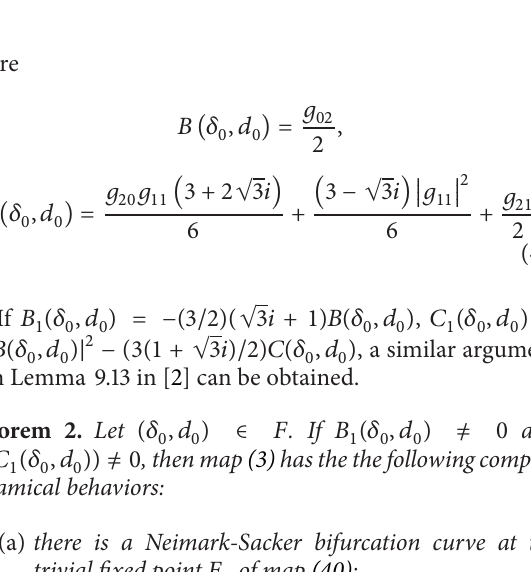
Figure 1: 1: 3 resonance bifurcation diagram at 𝐸 with 𝑎 = 2 , 𝑏 = 3 , 𝑐 = 0.8 , 𝑑 = 0.12428002 , and 𝛿 = 1.6771238 . (a) In ( 𝛿,𝑥 ) plane with 𝑑 = 0.12428002 . (b) In ( 𝛿,𝑥 ) plane with 𝑑 = 0.14 . (c) In ( 𝛿,𝑑, 𝑥 )